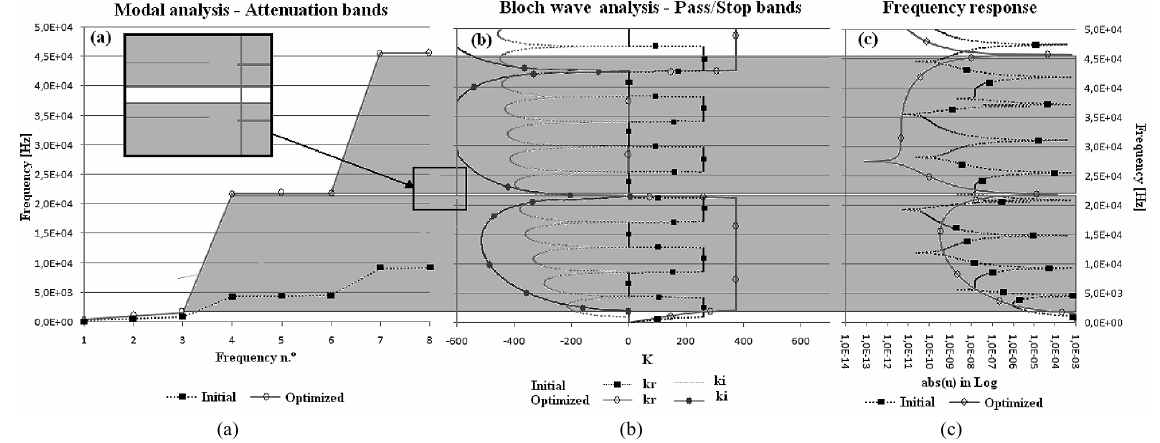
Fig. 9. Results for i = Ncel = 3 cells: a) Eigenfrequencies curve plot; b) Dispersion curves and c) Frequency response